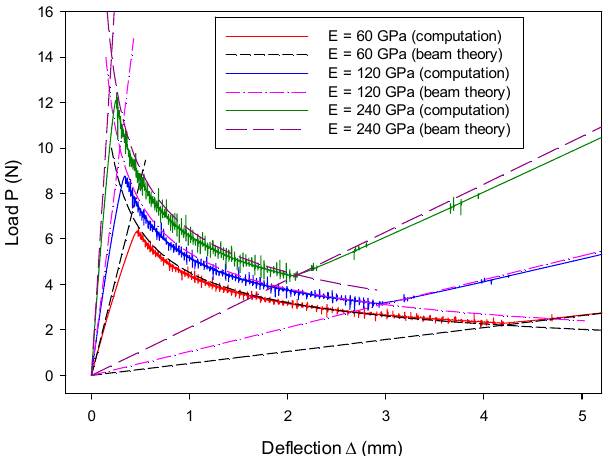
Figure 14. Young’s modulus effect on load–deflection relation.